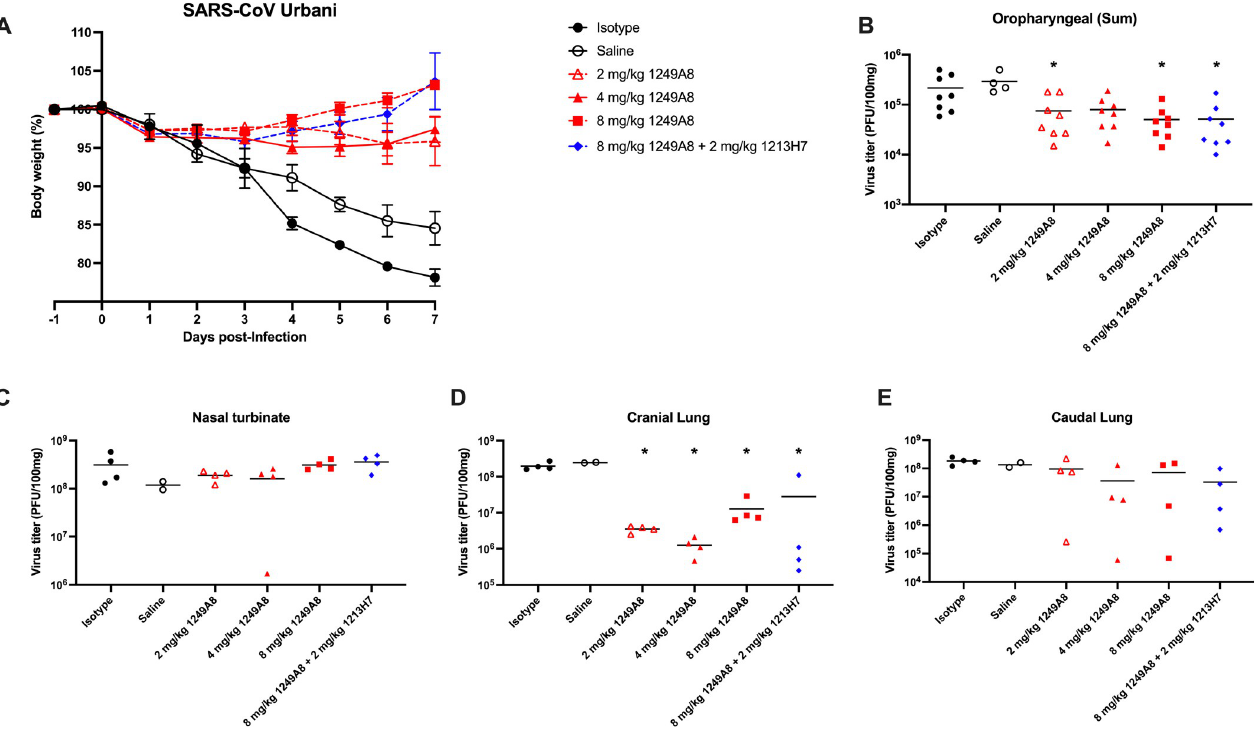
Fig 7. Therapeutic activity of intranasal 1249A8 and 1213H7 in hamsters infected with SARS-CoV. Golden Syrian hamsters were infected i.n. with 10 4 pfu SARS-CoV (SARS-Urbani) and 12 h p.i. treated i.n. with a single dose of indicated mAb(s). n = 4–8 per group. ( A ) Body weight was measured daily. Mean ± SEM indicated. ( B ) Oropharyngeal swabs were collected days 1, 2, and 3 p.i. and sum of daily virus titer for each animal indicated. Nasal turbinate ( C ), cranial lung ( C ), and caudal lung ( E ) viral titers were measured at 3 d p.i. by plaque assay. Each symbol represents an individual animal. � indicates p < 0.05 compared to isotype control group as determined by one-way